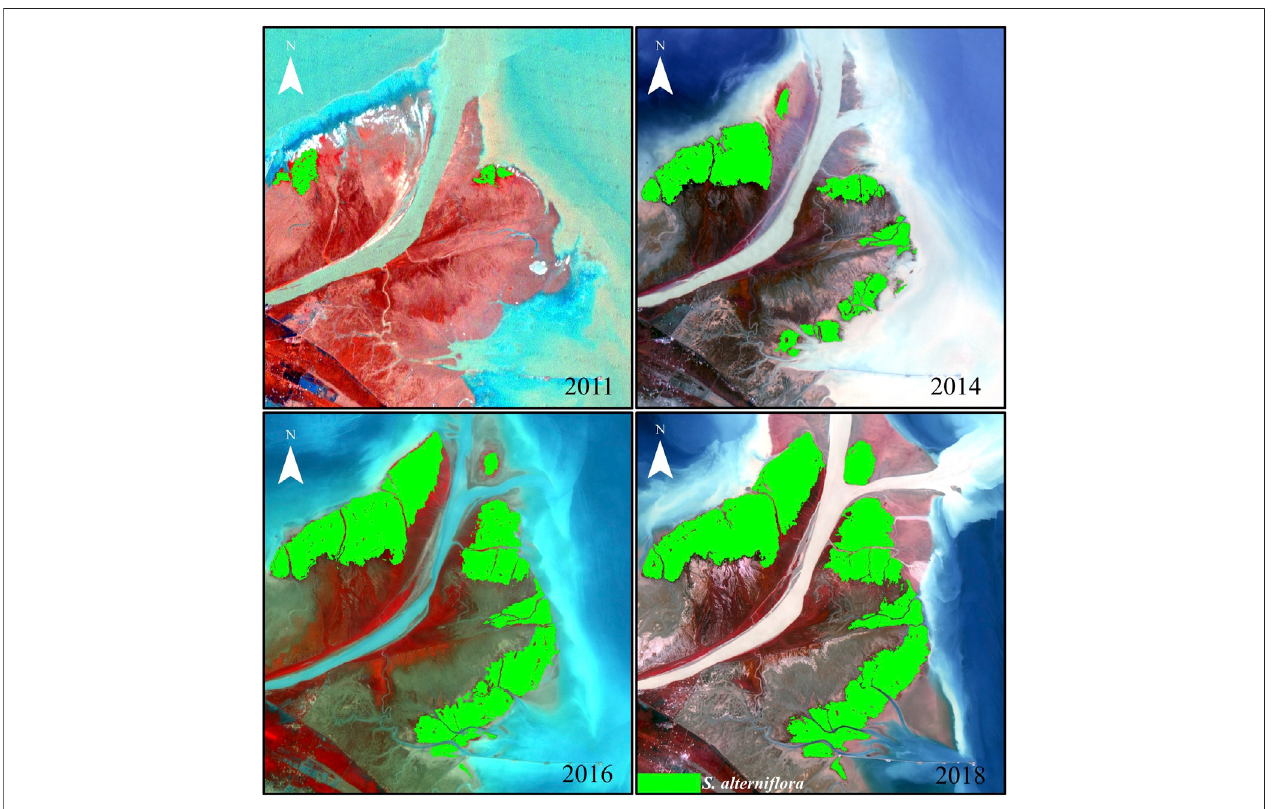
FIGURE 2 | S. alterni fl ora spatial distribution in December 11, 2011, September 22, 2014, September 11, 2016 and September 17, 2018,